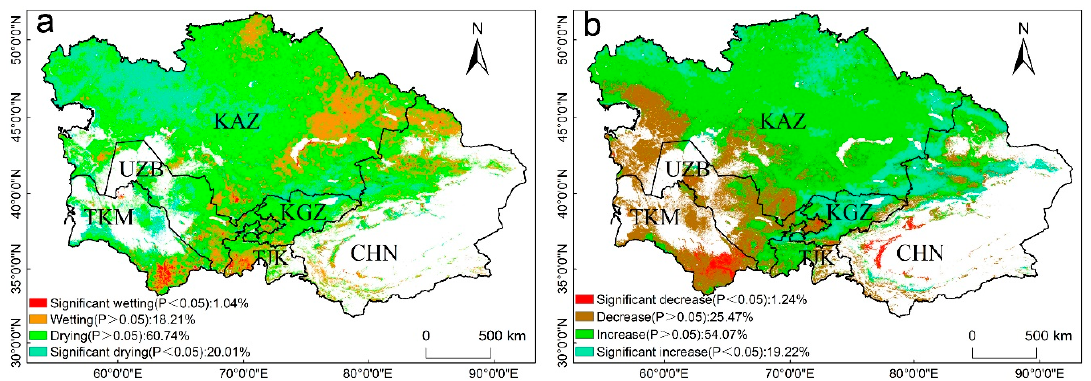
Figure 4. ( a ) Trend of annual temperature vegetation dryness index (TVDI) and ( b ) annual WUE in Central Asia from 2000–2014. White areas represent barren, snow, and water body pixels.